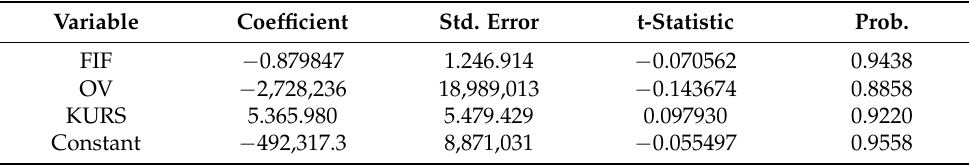
Table 11. Park Test.